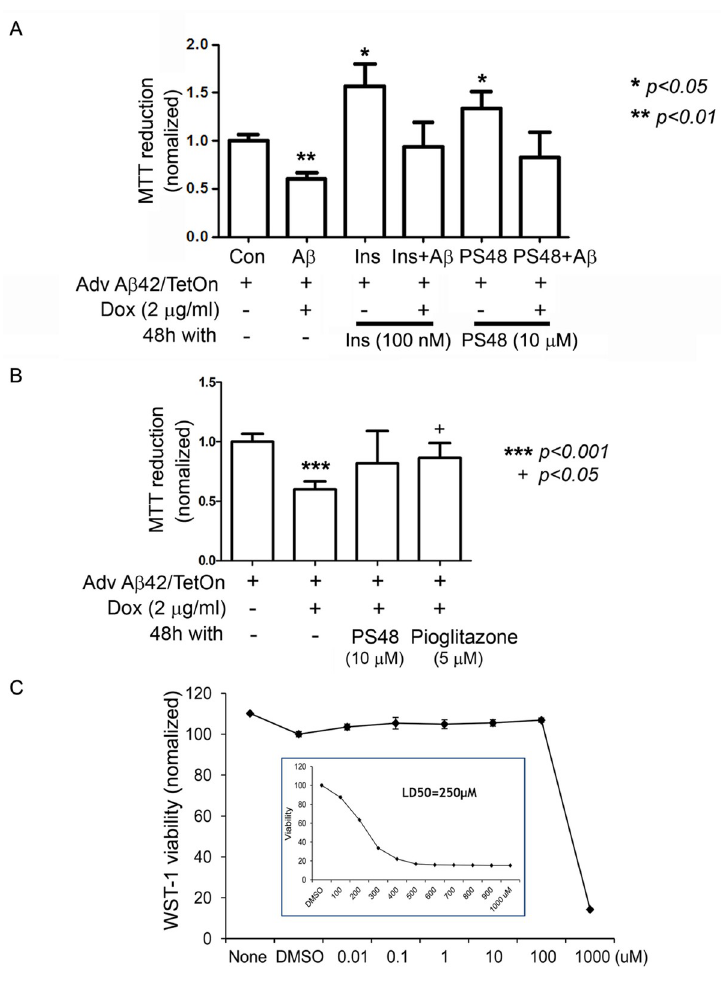
Fig 2. PS48 or Insulin partly restores partial viability in β -amyloid expressing cells. 2A . SH-SY5Y cultures infected with Adenovirus encoding A β 42 and induced with Doxycycline. Amyloid bearing cells are less viable in an